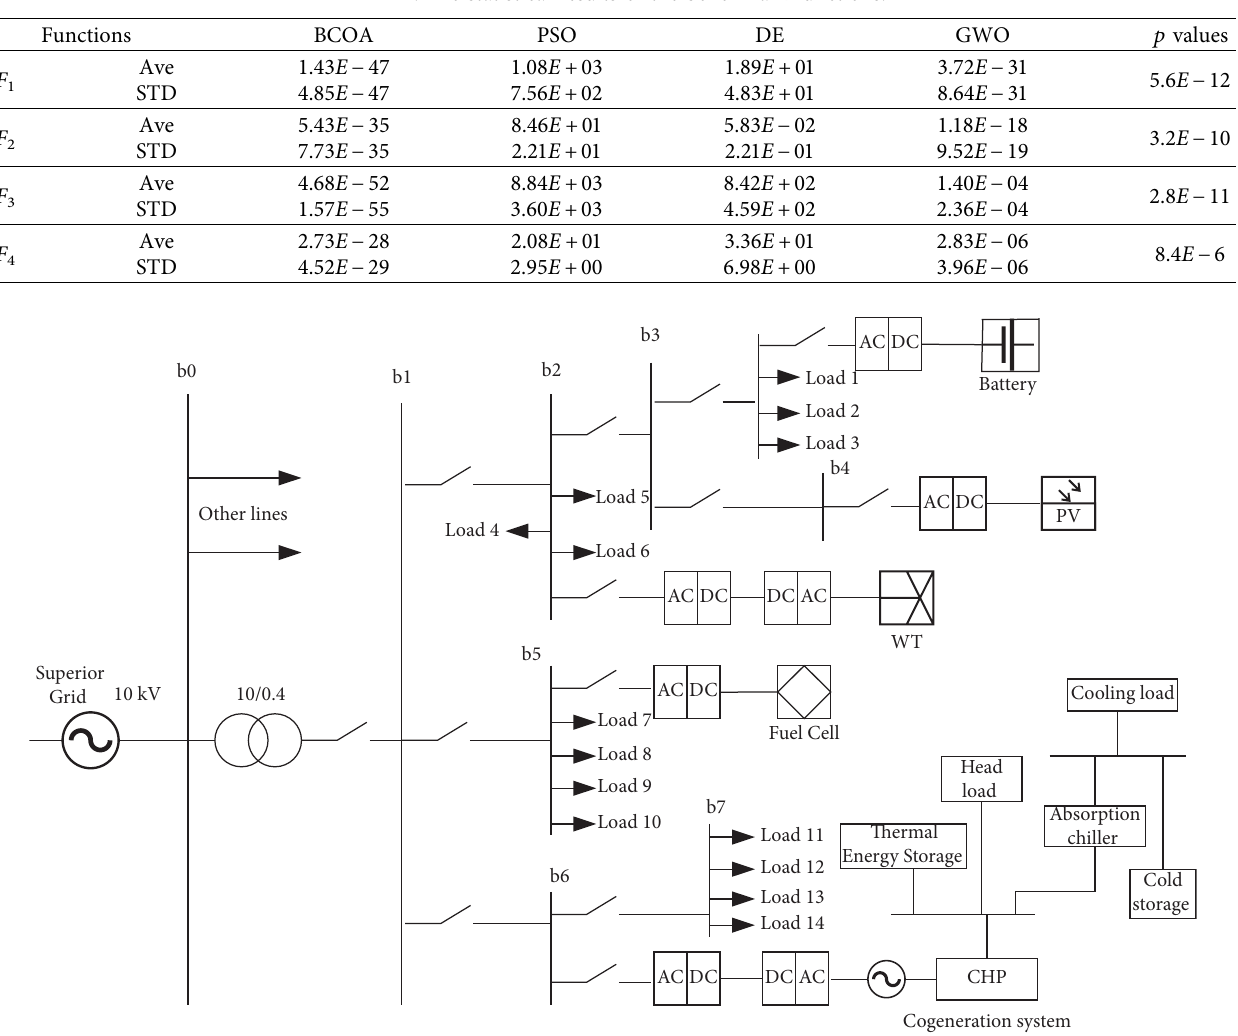
Table 2: Te statistical results of the benchmark functions.